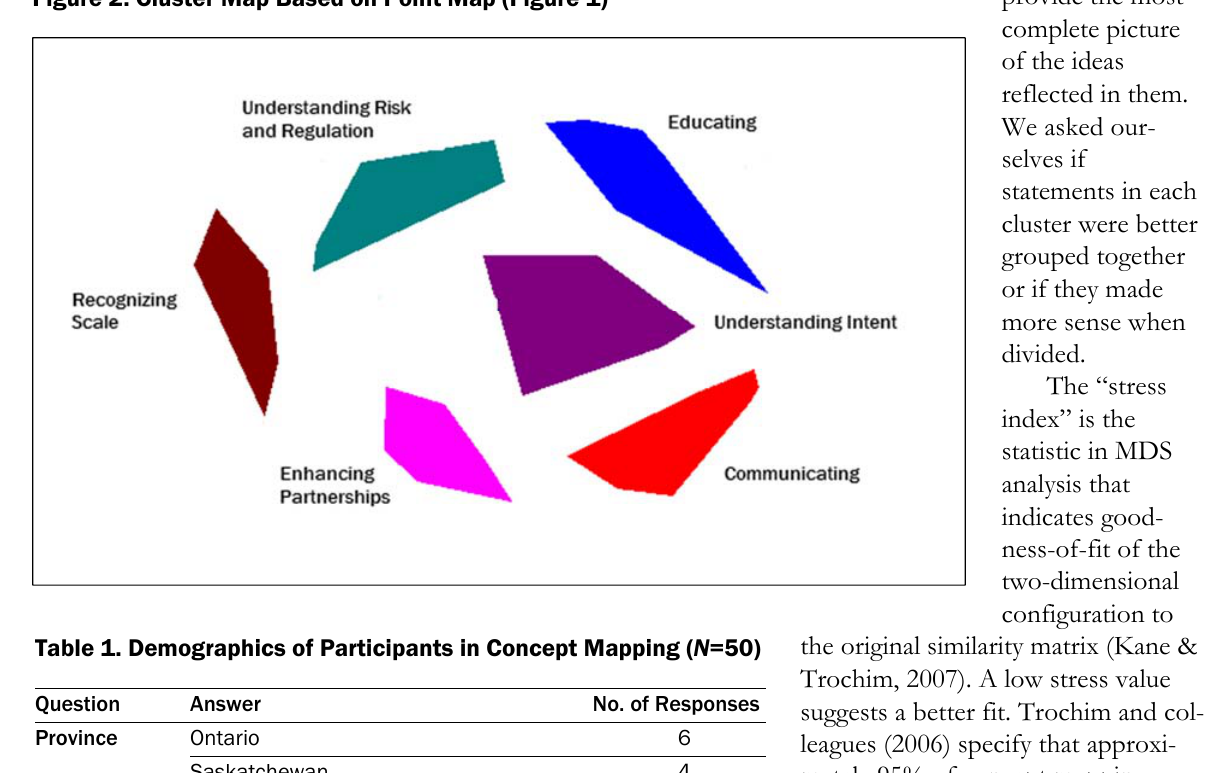
Figure 2. Cluster Map Based on Point Map (Figure